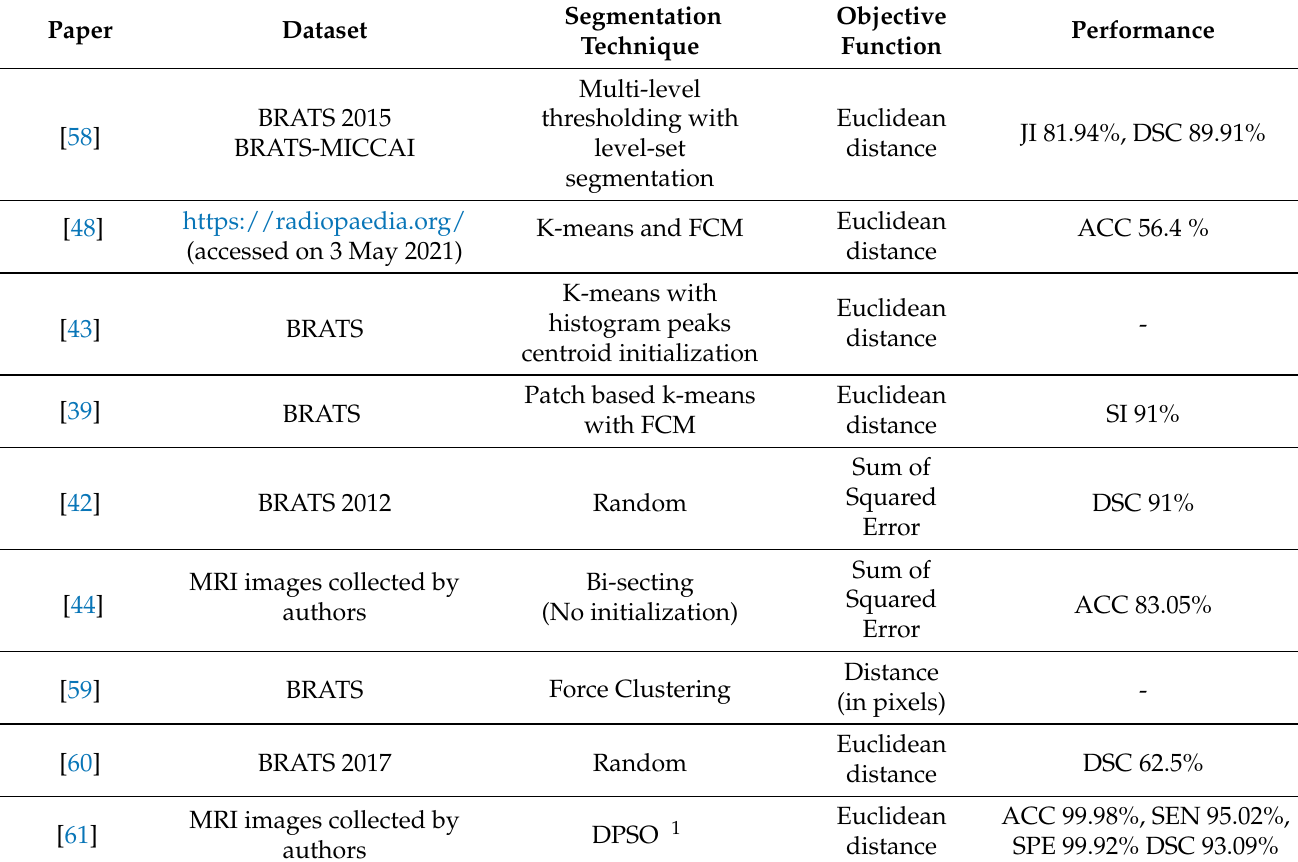
Table 3. Region growing and shallow unsupervised machine learning based brain tumor segmentation.